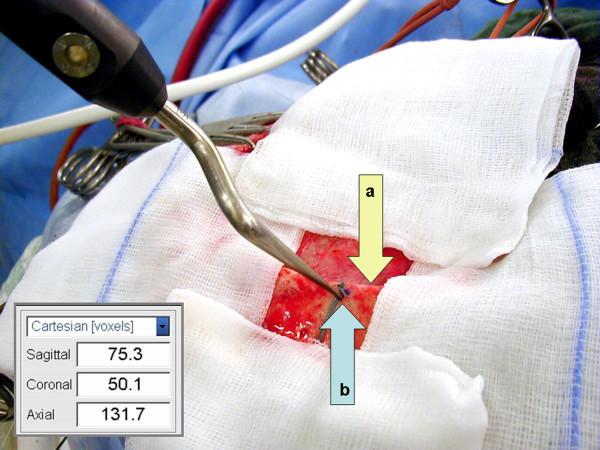
The application accuracy was monitored intraoperatively using as a reference point a 1 mm burr hole (b) drilled into the exposed bone margin (a) directly after craniotomy. The Cartesian coordinates of this reference point were used to calculate the intraoperative Position Error (PE = (Δsagittal 2 + Δcoronal 2 + Δaxial 2)1/2) in mm.